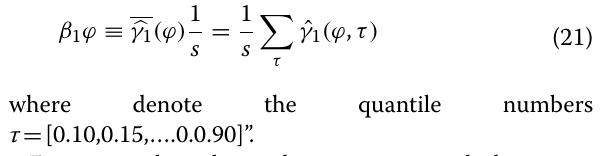
Table 2 COVID-19 and shipping freight correlation